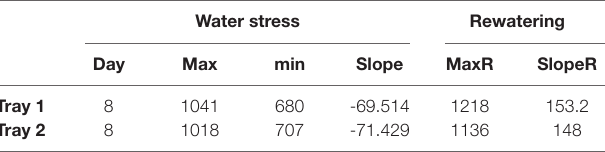
TABLE 1 | Traits related to water deficit and recovery. Traits were extracted from the linear regression of the canopy height in two randomly selected